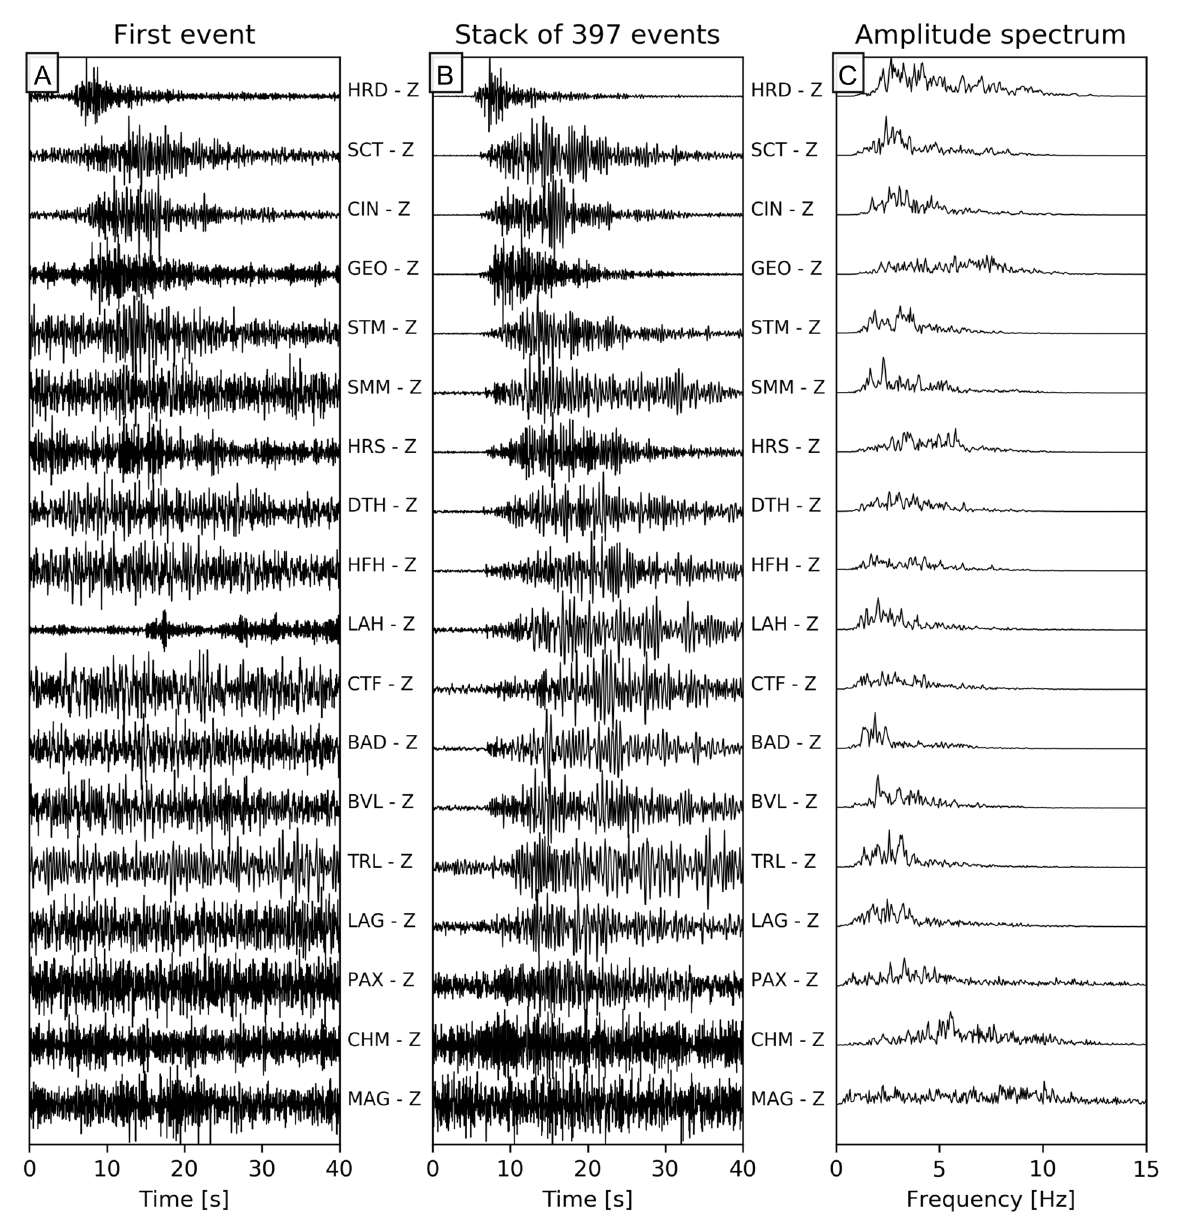
Figure 4: [A] The waveform of the first detected event in Family 1 as recorded at stations within the 2015 deploy- ment, ordered by distance from the summit. [B] Stacked waveforms generated from the 397 events detected in Family 1 at each station. [C] Normalized frequency-amplitude spectra of the stack waveforms presented in panel